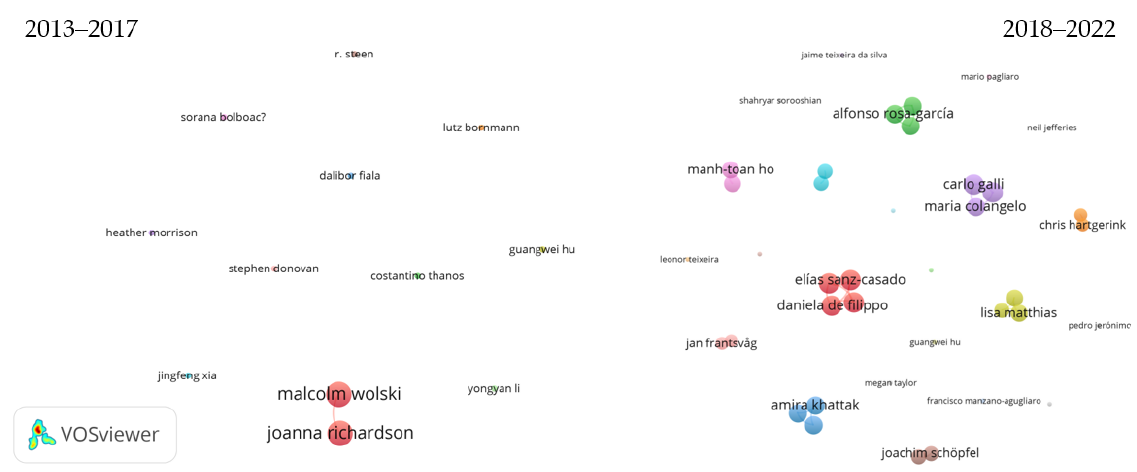
Figure 7. Author networks for both 5-year periods (n = 12 and n = 39, at least 2 documents). Node size indicates the total link strength. Source: VOSViewer.